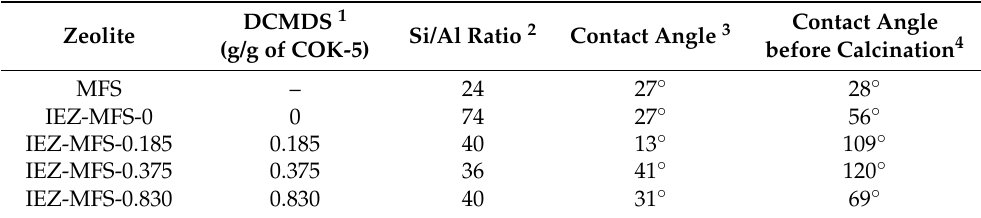
Figure 9. Contact angles of water on surface of COK-5, MFS, IEZ-COK-5, and IEZ-MFS produced using different amounts of DCDMS. Reprinted with permission from ref. [40]. Copyright 2015, Elsevier. Table 5. Physicochemical properties of MFS and IEZ-MFS under different conditions. Reprinted with permission from ref. [40]. Copyright 2015,